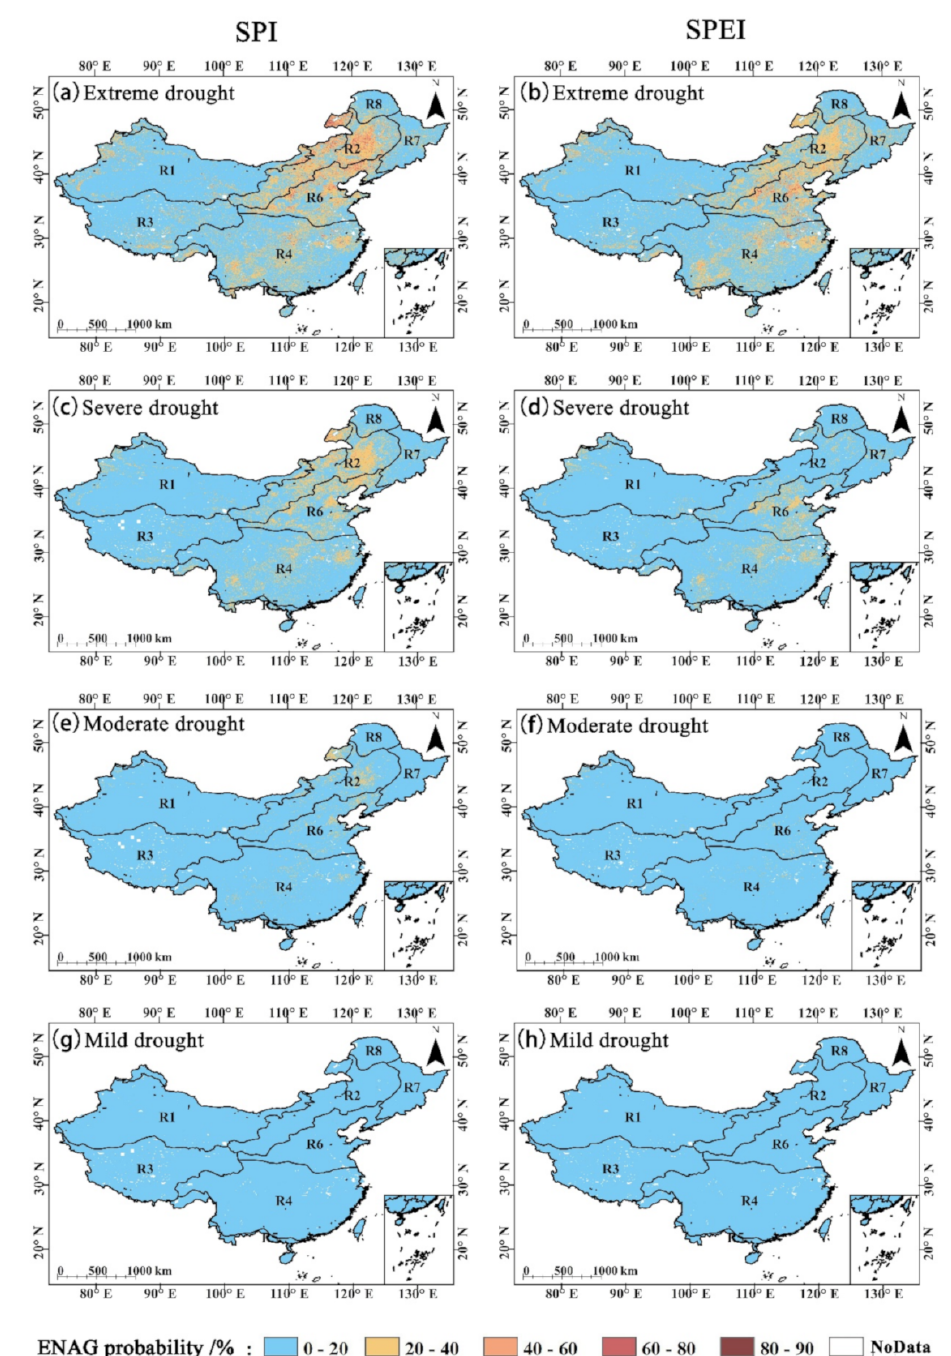
Figure 4. Spatial distribution of the probabilities of ENAG under different drought levels. ( a , c , e , g ) represent extreme, severe, moderate, and mild droughts classified in terms of the SPI, respectively; ( b , d , f , h ) represent extreme, severe, moderate, and mild drought classified in terms of the SPEI, respectively. (Note: The copula function cannot be built in the pixels where the GPP data are missing or the GPP value is constant in all years. Those pixels were removed and are shown as